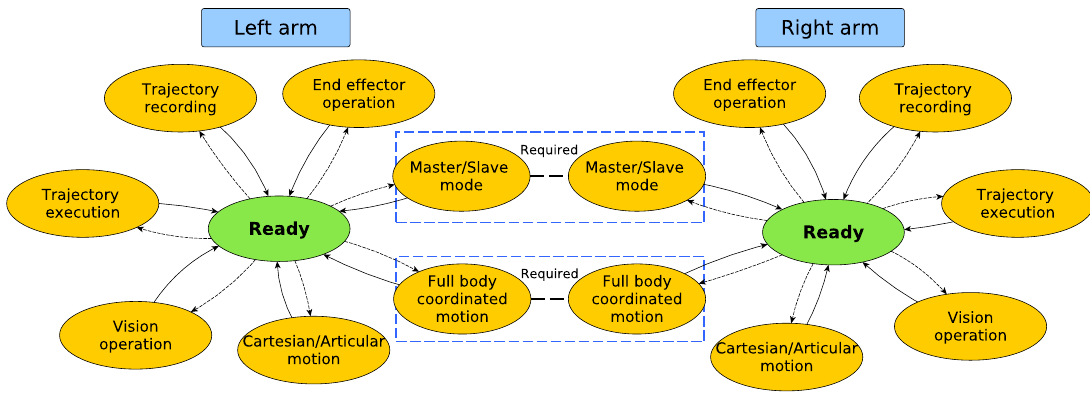
Figure 3. Proposed state machine-based architecture. The figure represents an overview of the